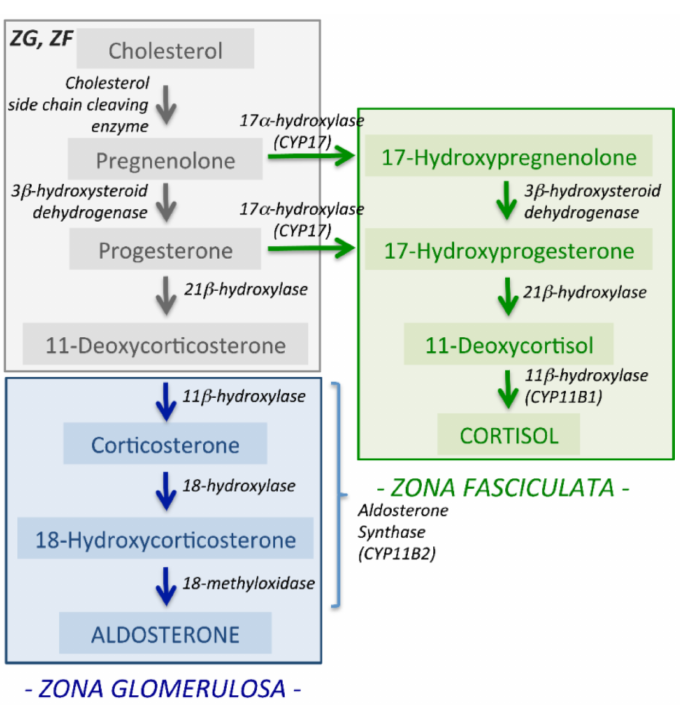
Figure 1. Aldosterone synthesis in the adrenal cortex. Aldosterone is synthesized in the zona glomerulosa (ZG) distinct from the synthesis of cortisol in the zona fasciculata (ZF). Aldosterone synthase encoded by CYP11B2 performs all three enzymatic steps in the conversion of deoxycorticosterone to